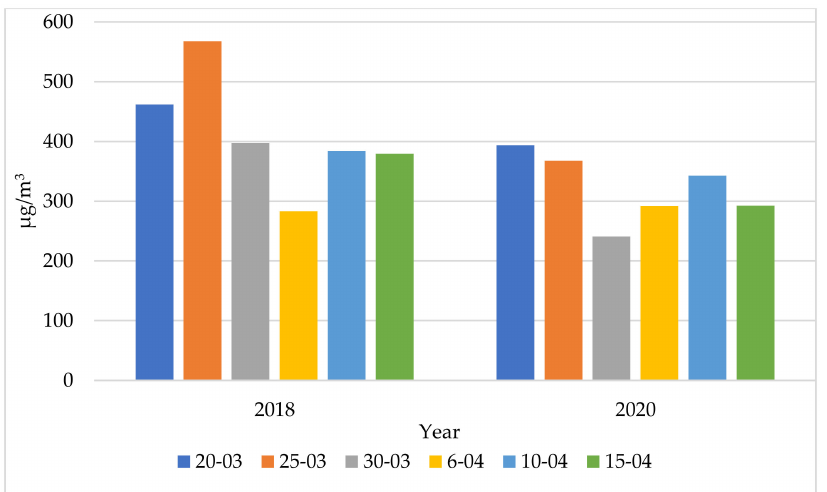
Figure 11. CO concentration in Warsaw on individual days of 2018 and 2020. Source: Own elabora- tion, based on data from Copernicus Atmosphere Monitoring Service (CAMS)